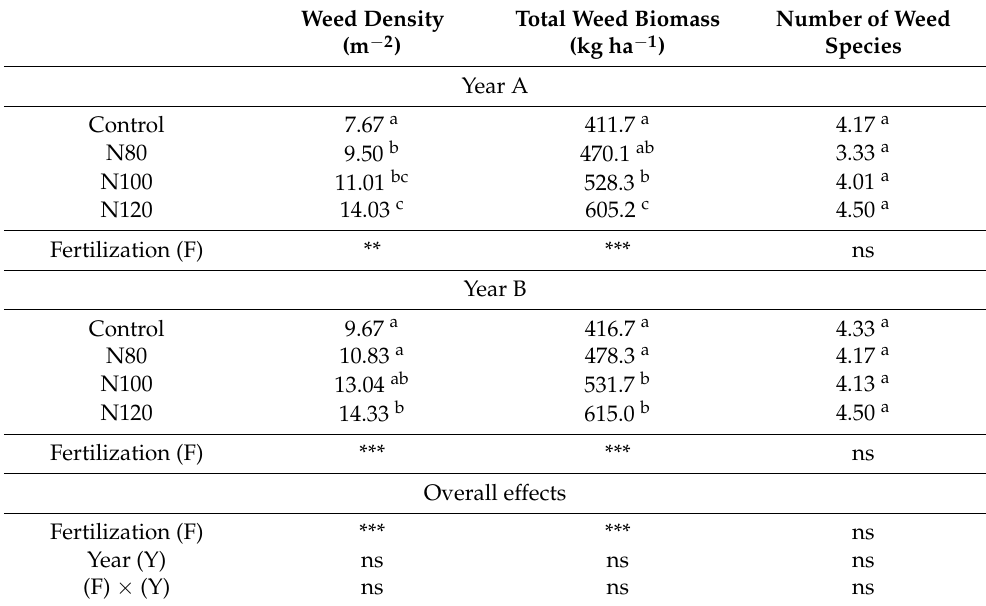
Table 4. Weed density, biomass, and number of different weed species as affected by the different N fertilization